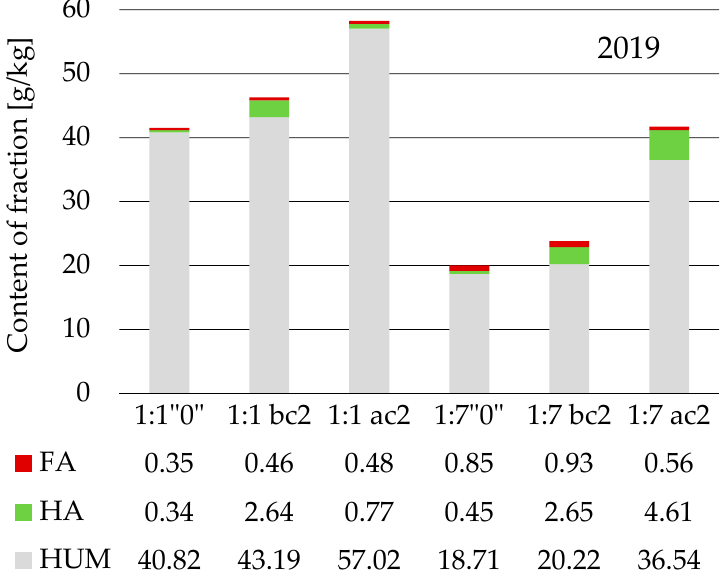
Figure 10. The content of humic substances in soils from pot experiment in 2019. With the addition of carbons, the contents of FA in soils in 2019 were similar to those on the day that the pot experiment was set up (in 2011). The addition of carbons caused an increase in the contents of HA and HUM. The duration of the experiment did not cause an increase in the contents of HUM, as their quantities in soils with brown coal and activated carbon did not change